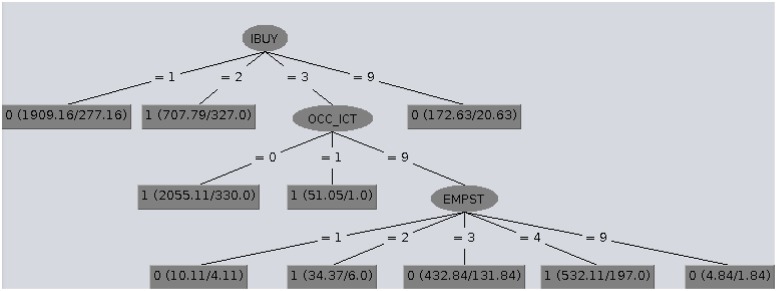
CTC tree obtained for Denmark which has a very high EGUI+ level.